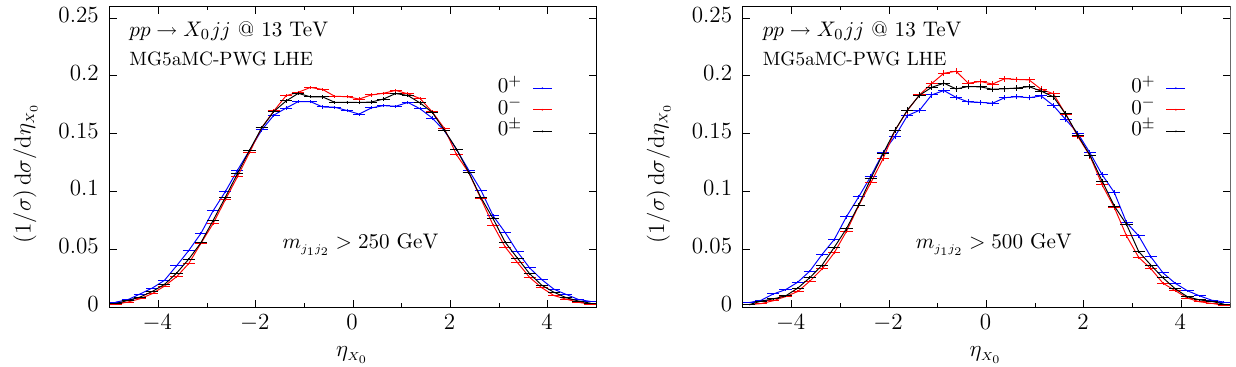
Fig. 3 Normalised differential cross section as a function of the pseudorapidity of the spin-0 boson X 0 , for the three CP scenarios. On the left panel, a cut of 250 GeV is imposed on the dijet mass, while on the right panel a cut of 500 GeV is applied. The colour code is the same as in Fig. 1